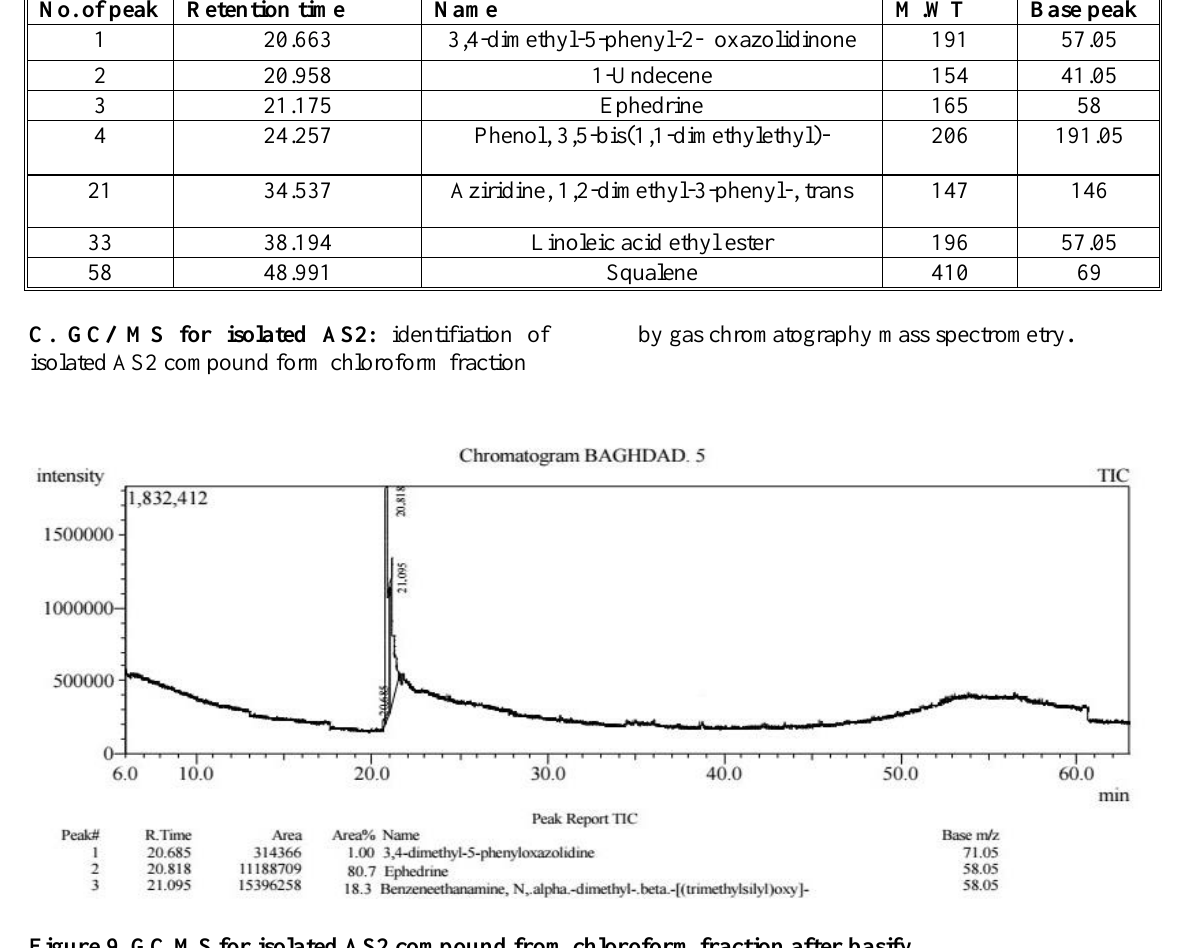
Figure 9. GC MS for isolated AS2 compound from chloroform fraction after